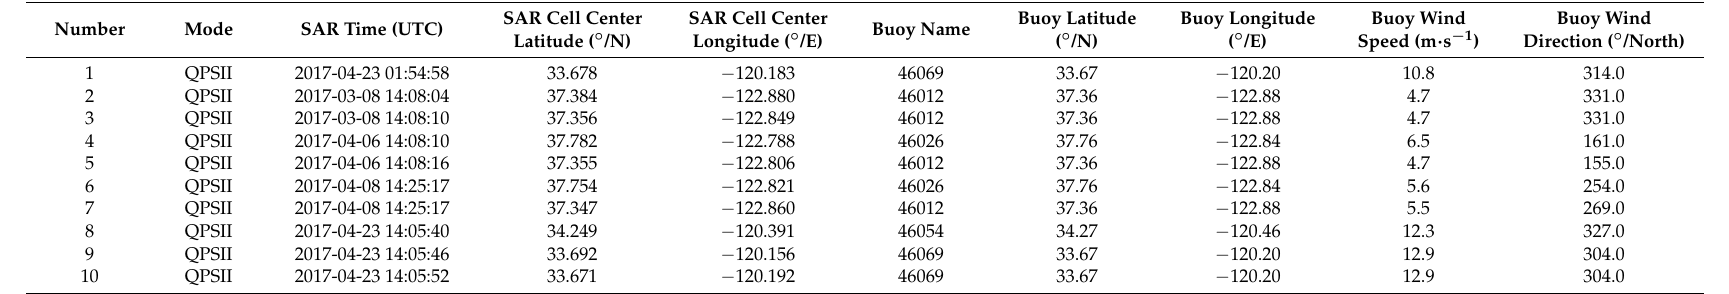
Table 2. Details for collocations of GF-3 quad-polarization data and NDBC buoy